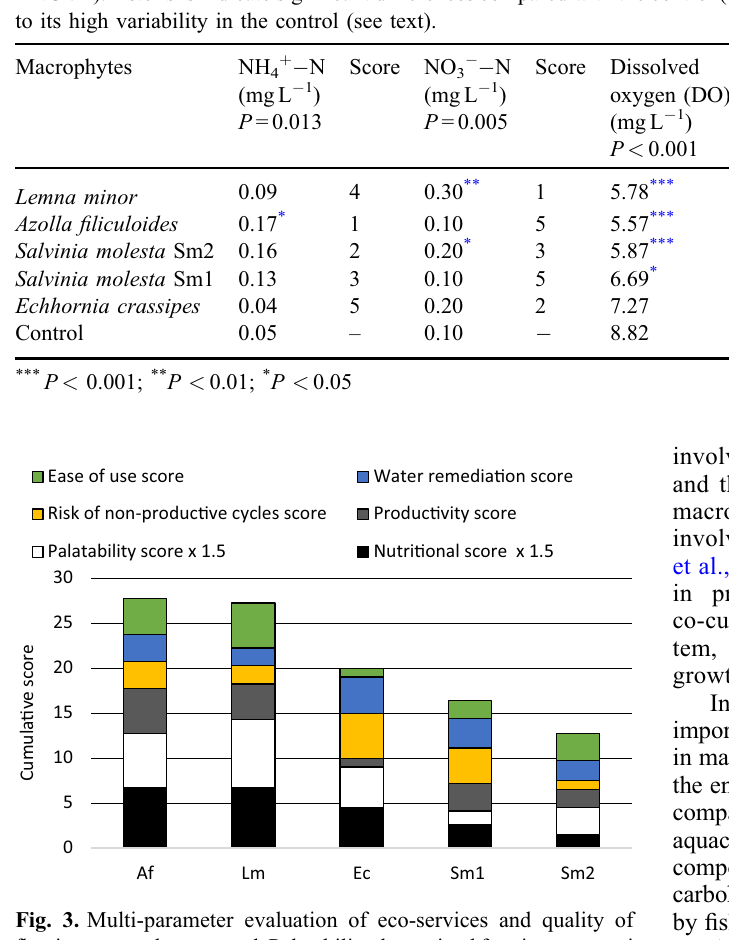
Fig. 3. Multi-parameter evaluation of eco-services and quality of fl oating macrophytes tested. Palatability determined for giant gourami ( Osphronemus goramy ). Af: Azolla fi liculoides ; Lm: Lemna minor; Ec: Echhornia crassipes; Sm1: Salvinia molesta type1; Sm2: Salvinia molesta type 2.